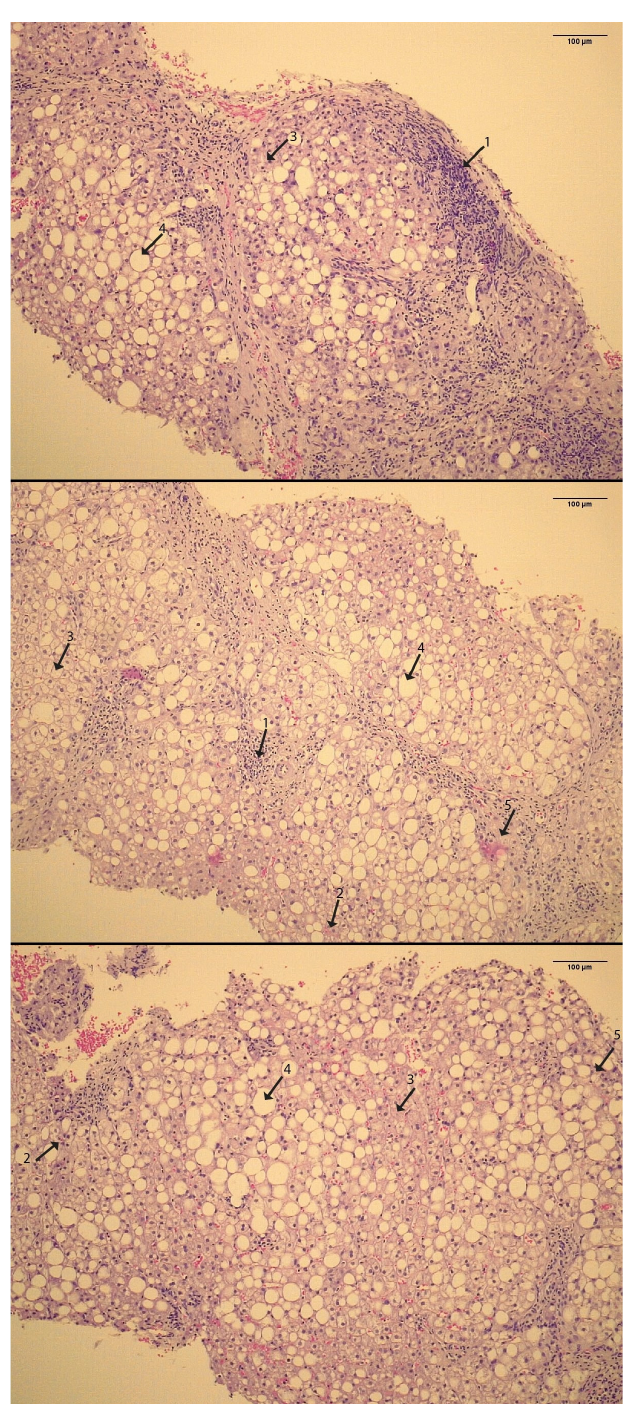
Figure 1. Liver biopsy of non-alcoholic steatohepatitis (NASH) stage 3 (severe fibrosis). Portal spaces are normal size or slightly dilated, connected by septa of connective tissue that sometimes surround parenchymal nodules. They are moderately to strongly infiltrated with lymphocytes and rare granulocytes. The parenchyma is partially nodularly transformed, and rare focal necrosis is present. Hepatocyte joists are focally thickened. Focal glycogenization of hepatocyte nuclei is present. Ballooned hepatocytes are numerous. Coarse-grained fatty change is diffuse. Kupffer cells multiply in the sinuses. There are numerous foci of perisinusoid necrosis. Hematoxylin and eosin (H&E) staining, 10 × Legend: 1, lymphocytes; 2, focal necrosis; 3, ballooned hepatocytes; 4, fat accumulation; 5, Kupffer